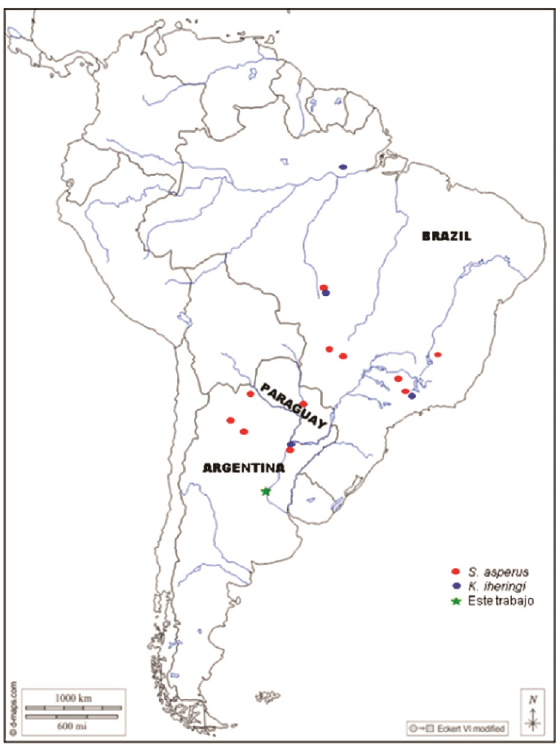
Figure 4. Records of Spinitectus asperus and Klossinemella iheringi in South